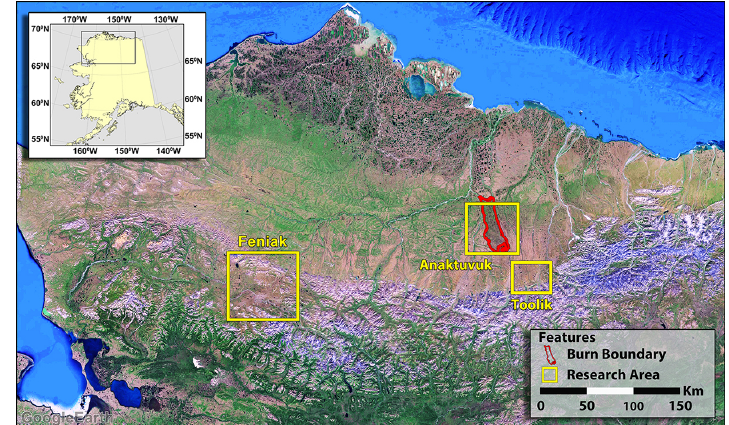
Figure 1. Map of study areas. Map credit: J. Noguera and R. Fulweber, Toolik Field Station GIS and Remote Sensing